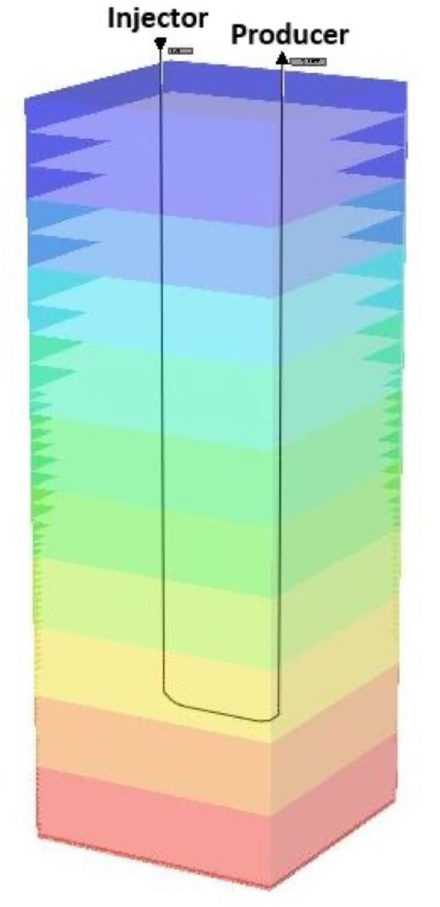
Fig. 2 U-Tube well